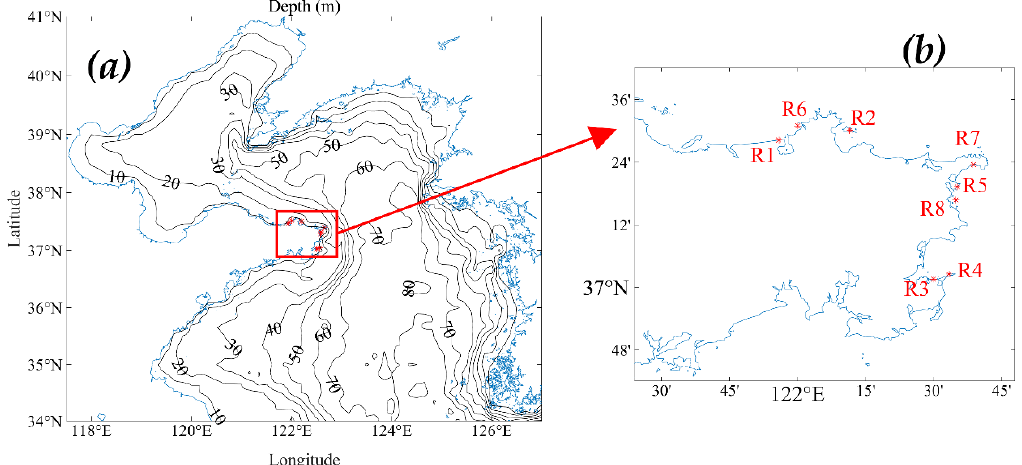
Figure 3. ( a ) Topography of the study site (depth in meters) and locations of marine ranches (red asterisks in red rectangle). ( b ) The location of marine ranches. R1–R8 represent the Beihai Ranch,